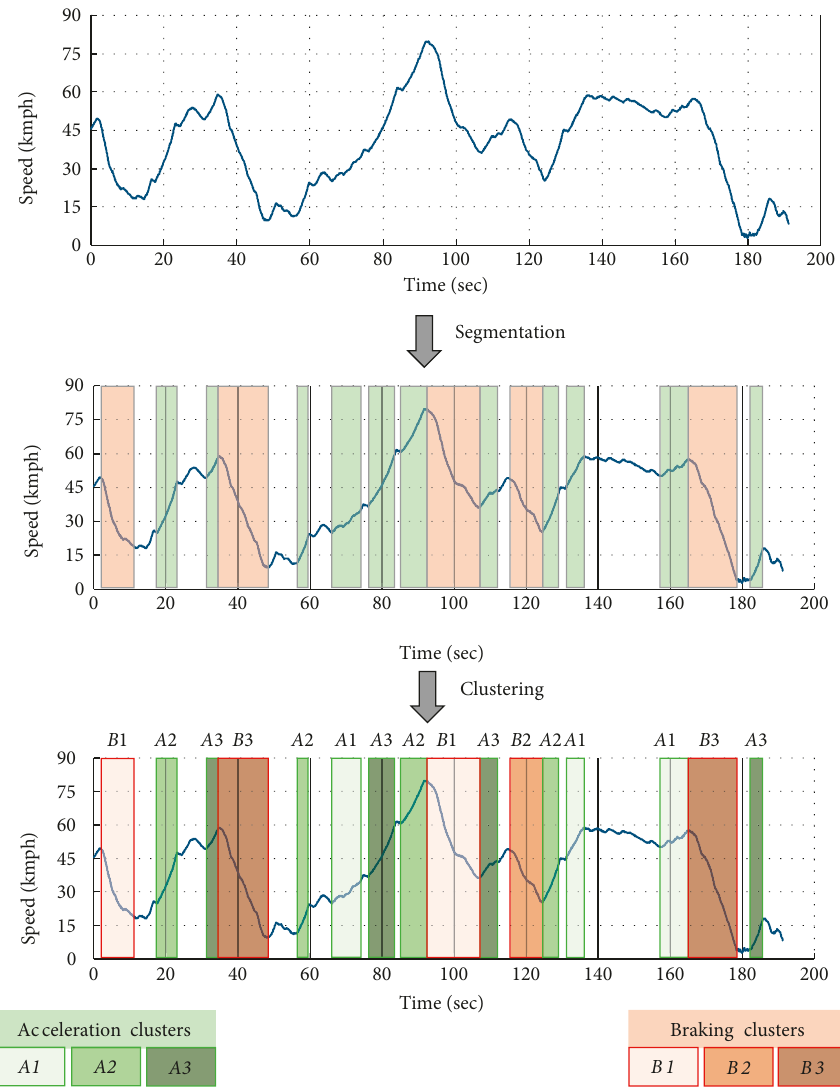
Figure 3: Illustration of segmentation and clustering process.